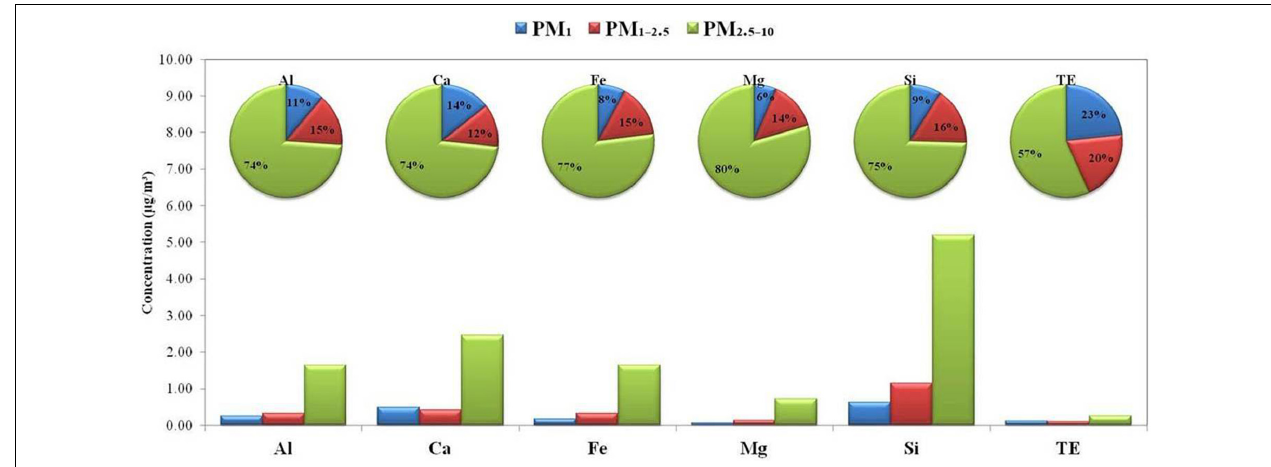
FIGURE 6 | Size distributions and contributions of the elemental